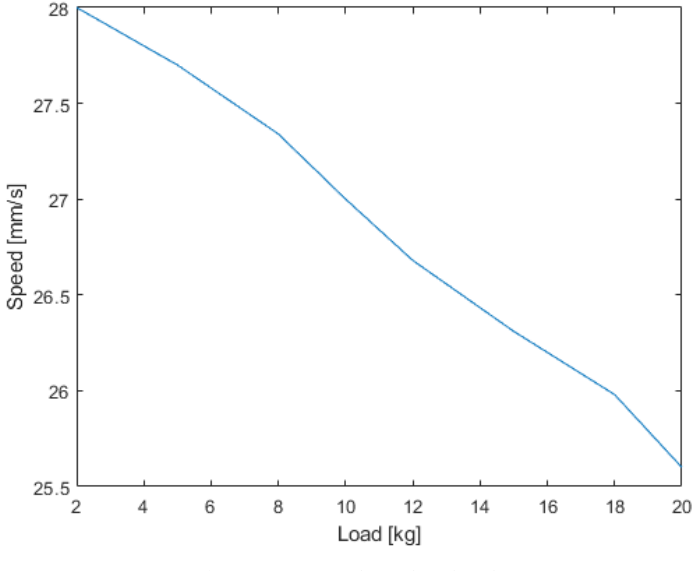
Figure 5. Speed vs. load